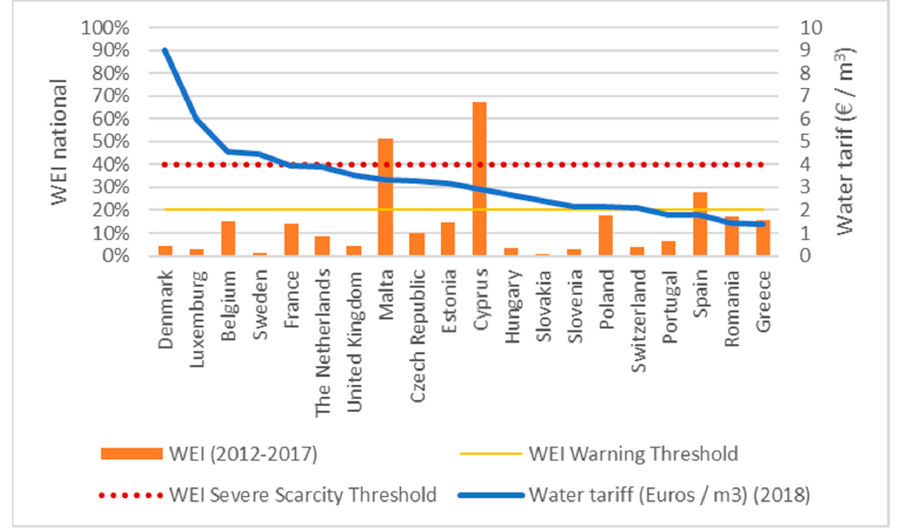
Figure 1. Water prices across European cities (€/m 3 ) [12] in comparison to the water exploitation index (WEI) [13].